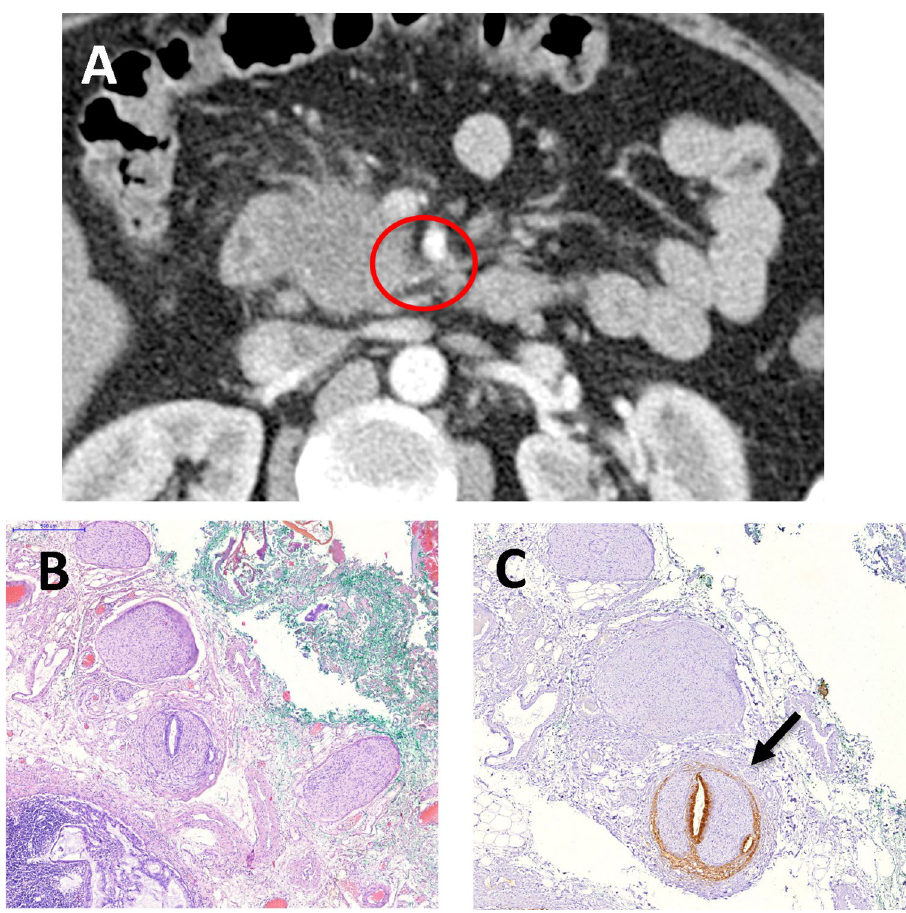
Figure 3. CT-examination obtained with intravenous contrast material ( A ) and microscopic specimen ( B , C ) of a 64 years old male patient with adenocarcinoma of pancreatic head. ( A ) Axial CT scan in arterial phase reveals the area of soft tissue attenuation along the course of IPDA. There is a contact to SMV < 180 with no signs of infiltration of SMA, so the primary tumor was evaluated as resectable. ( B , C ) The pathological section on the corresponding level to CT scan with hematoxylin and eosin staining. ( B ) The medial resection margin is inked with green stain. ( C ) Immunohistochemistry examination shows an expression of mucin Typ I in the tumor cells, which is marked with brown staining (arrow), demonstrating extrapancreatic perineural invasion.